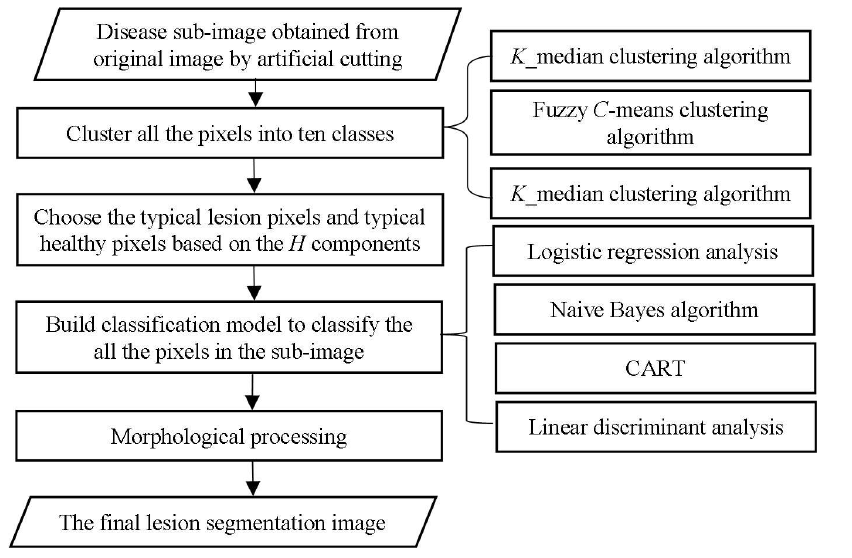
Fig 1. Work flow diagram of main steps for lesion image